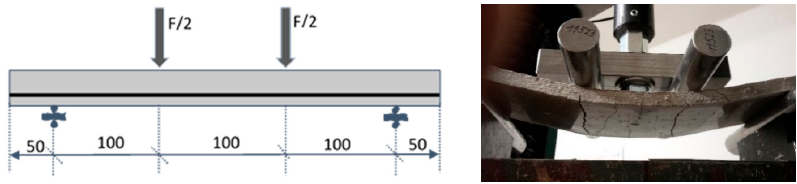
Figure 4. Four-point bending test for the thin plate specimens.